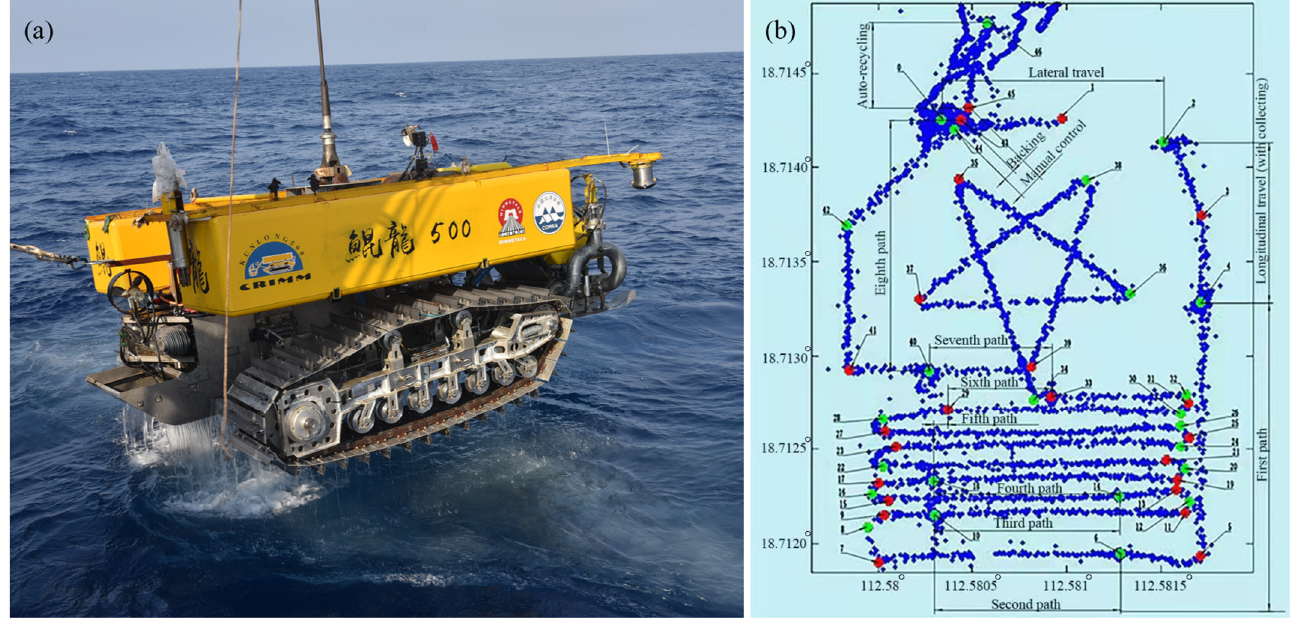
Figure 2. Seabed walking test of collector prototype of COMRA. ( a ) The collector test prototype of COMRA ( b ) The travel path of the test prototype on the seabed [44]. (The abscissa represents longitude and the ordinate represents latitude. In this trial, the combination of ultra-short baseline and long baseline was used for navigation. The blue dots in Figure 2 represent signals collected from ultra-short baselines, while the red and green dots represent signals collected from long